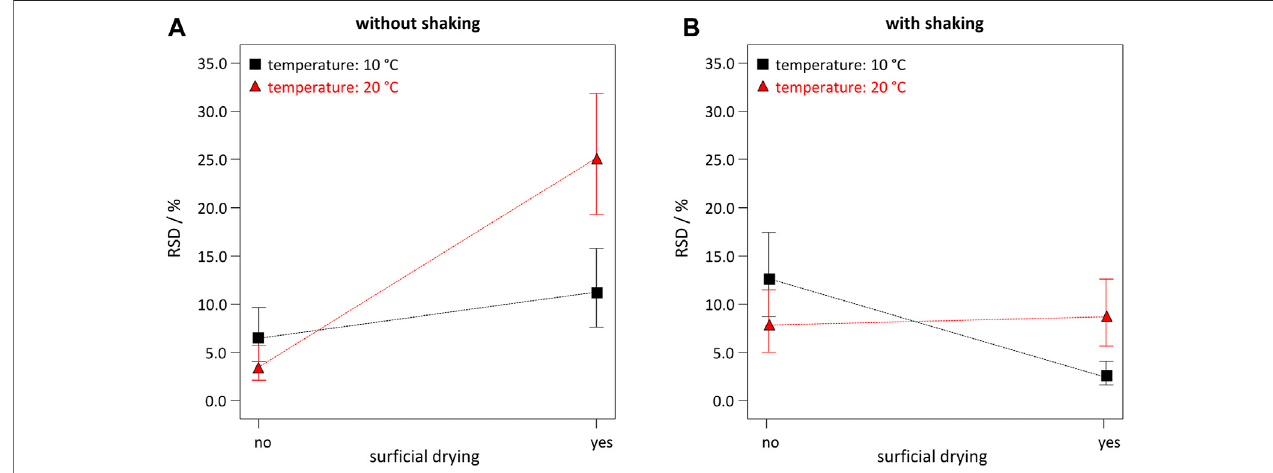
FIGURE2 | Interaction plots for correlationsbetween RSD and the 2FI BJ (temperature · drying). Plots were obtained for following settings: β BSA (cid:1) 10 g L − 1 , t (cid:1) 10 min, D (cid:1) 200 kGy, no EtOH, with pre-wetting step, and (A) without shaking; or (B) with